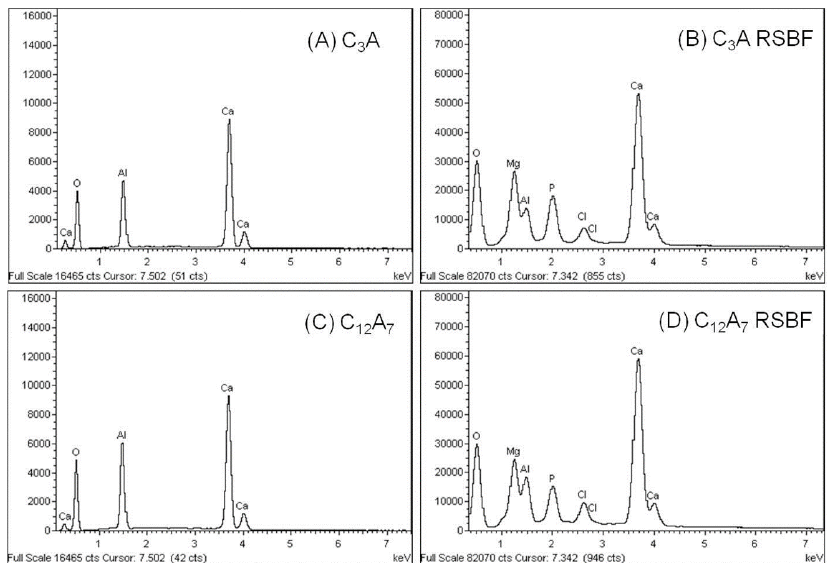
Figure 3. EDX spectra of the surface of the phases before immersion in SBF: (A) C RSBF, (D) C